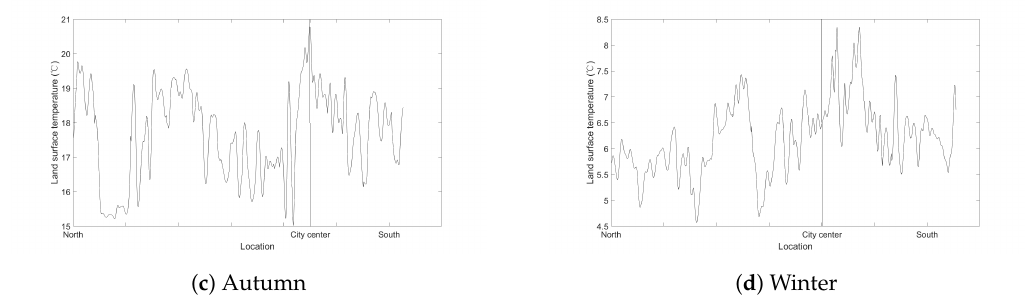
Figure 9. Seasonal land surface temperature ( ◦ C) along the north to south transect in Geneva.